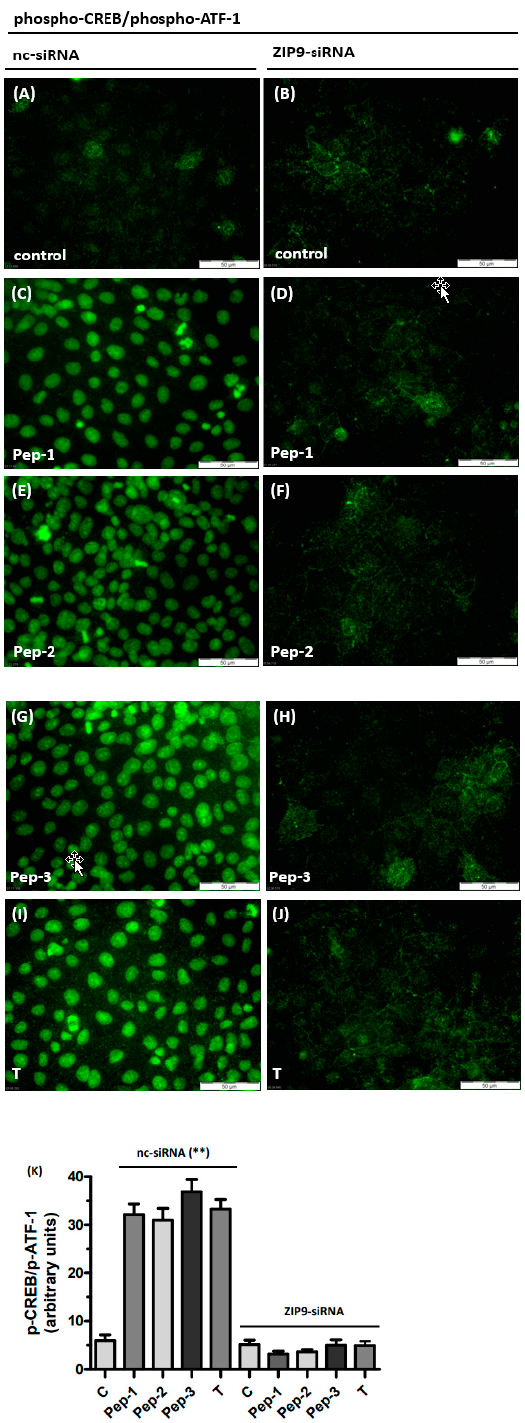
Figure 6. Detection of phospho-CREB/phospho-ATF-1 in Sertoli cells by immunofluorescence. The 93RS2 cells were treated with 10 nM of T or 10 µM of each of the peptides for 30 min. Nuclei are stained blue, the two transcription factors are represented by the green fluorescence. Cells were treated either with negative control siRNA ( A , C , E , G ,I) or with ZIP9-directed siRNA ( B , D , F , H , J ). ( A ) Phospho-CREB/phospho-ATF-1 in control cells. ( C ) Phospho-CREB/phospho-ATF-1 in cells treated with Pep-1, ( E ) in cells treated with Pep-2, ( G ) in cells treated with Pep-3 and ( I ) in cells treated with T. When ZIP9 expression is silenced by siRNA peptides or T fail to stimulate Erk1/2 phosphorylation( B , D , F , H , J ). ( K ) Statistical analysis of green fluorescence shown in panels A-J (n = 3 × 25; means ± SEM; ** p ≤ 0.01).